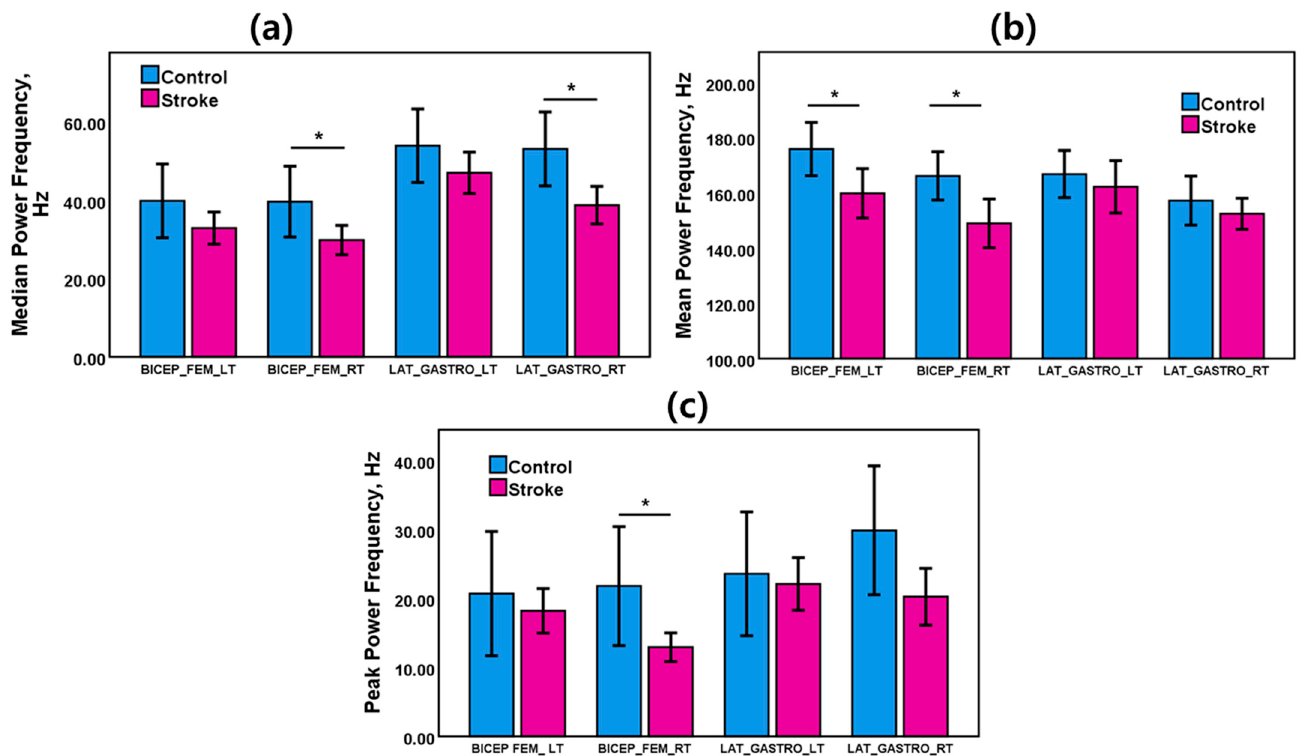
Figure 3. Bar charts with error bars of ( a ) median power frequency (MDF), ( b ) mean power frequency (MNF), and ( c ) peak power frequency (PKF) for the stroke group and the control group during the gait task. The bar charts represent the mean values, and the error bars show 95% confidence intervals ( ± 95% C.I.) * ( p < 0.05) indicates a significant difference ( t -test). Table 1. Results of the statistical analysis of the EMG features of the control and the stroke group. * Indicates p < 0.05. EMG Features